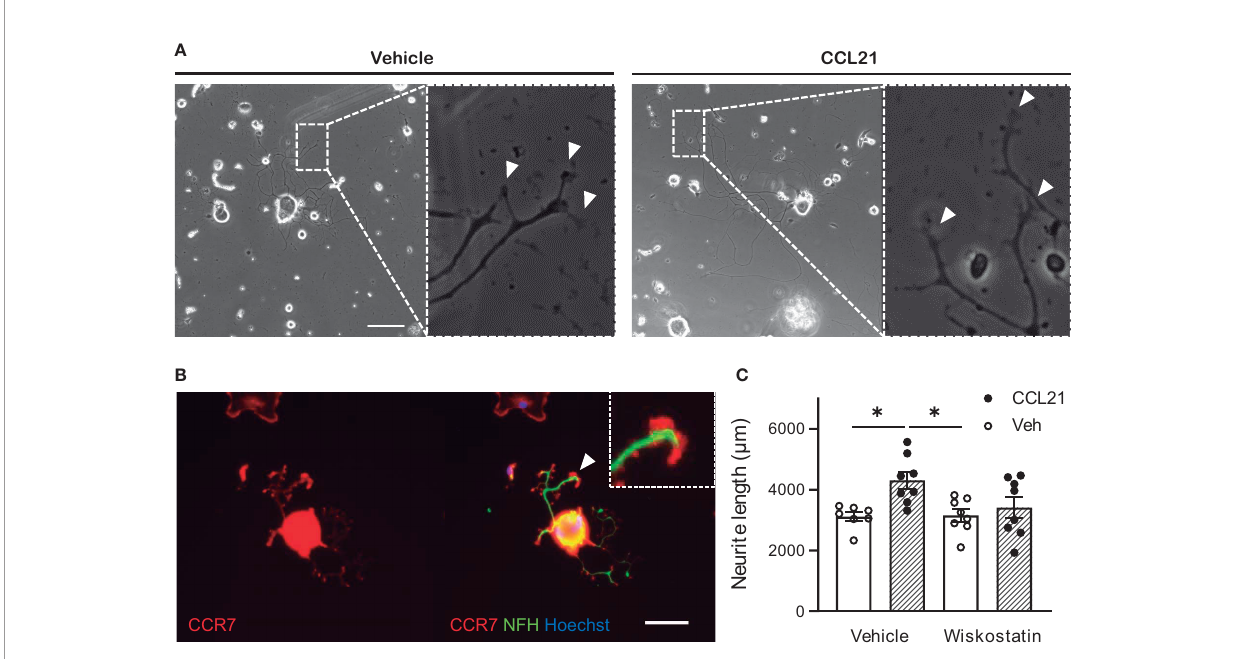
FIGURE 5 | CCL21 stimulates actin dynamics in the growth cone. (A) CCL21 administration resulted in enlarged growth cones in large-diameter DRG neurons. White arrows: growth cones. Scale bar: 100 m m. (B) CCR7 expression is specially elevated in the growth cone. Scale bar: 50 m m. (C) Actin branching is important for CCL21-dependent neurite outgrowth, as shown by impaired growth after wiskostatin treatment. Data are expressed as average neurite length per neuron ± s.e.m; One-way ANOVA, Bonferroni ’ s post-hoc ; * p < 0.05; n=7-8